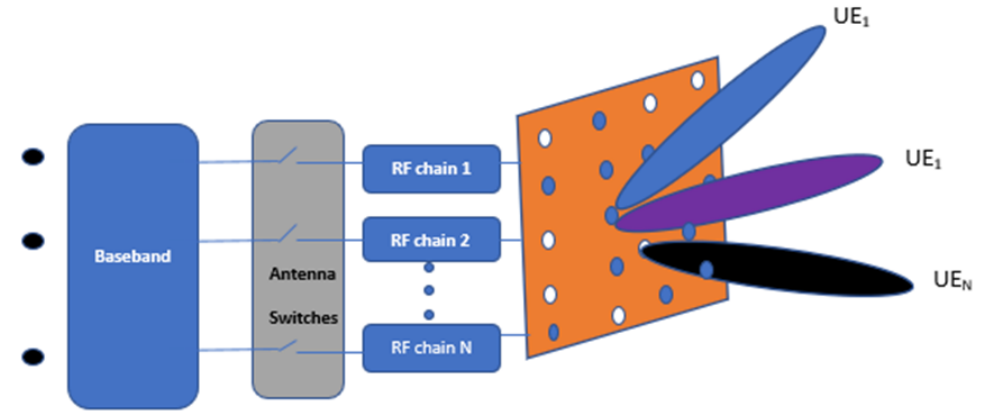
Figure 1. Digital beamforming URA